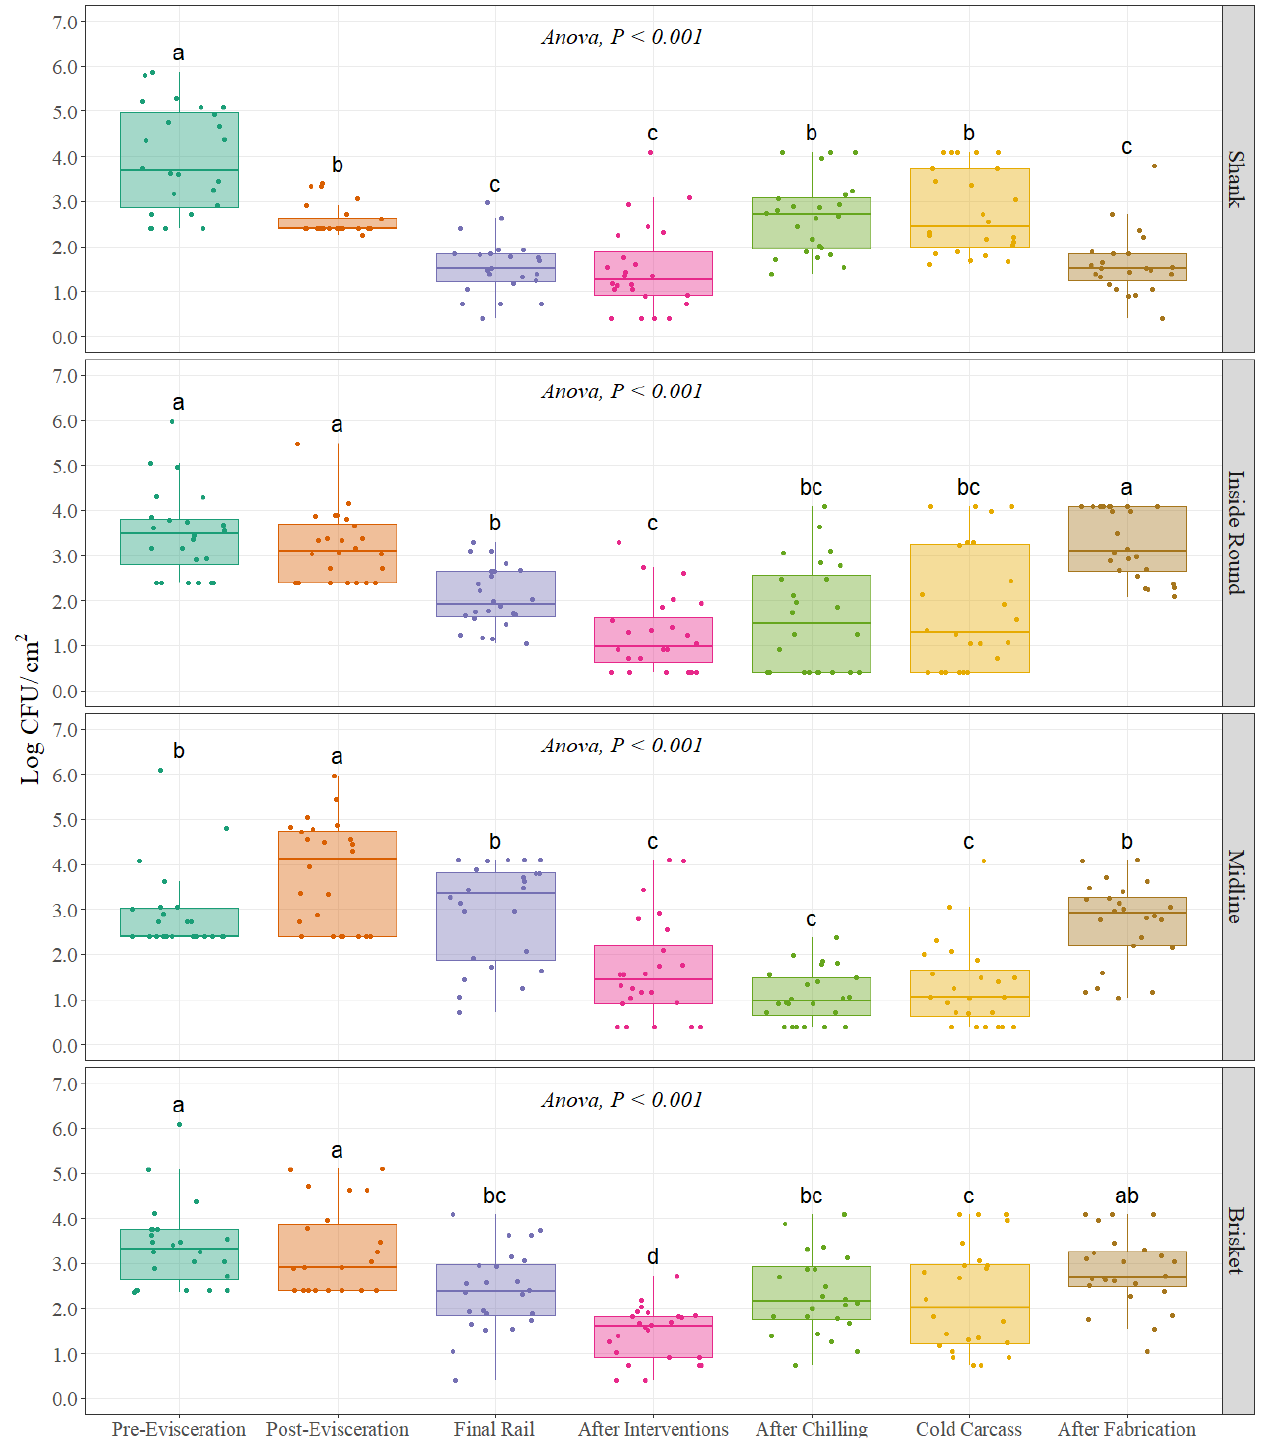
Figure 1. Mesophilic aerobic plate counts (Log CFU/cm 2 ) at different carcass regions throughout different sampling locations of the beef processing line (n = 24 swabs per carcass region/sampling location). In each boxplot, the horizontal line crossing the box represents the median, the bottom and top of the box are the lower and upper quartiles, the vertical top line represents 1.5 times the interquartile range, and the vertical bottom line represents 1.5 times the lower interquartile range. (a – d) For each individual carcass region, boxes with different letters are significantly different according to ANOVA analysis followed by a pairwise comparison t -test at p < 0.05. The points represent the actual data points.